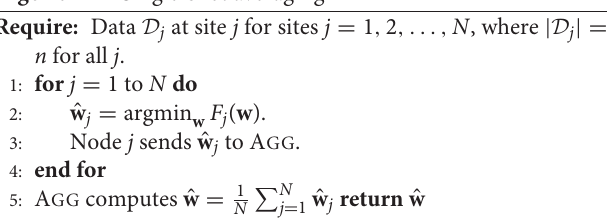
Algorithm 1 Single-shot